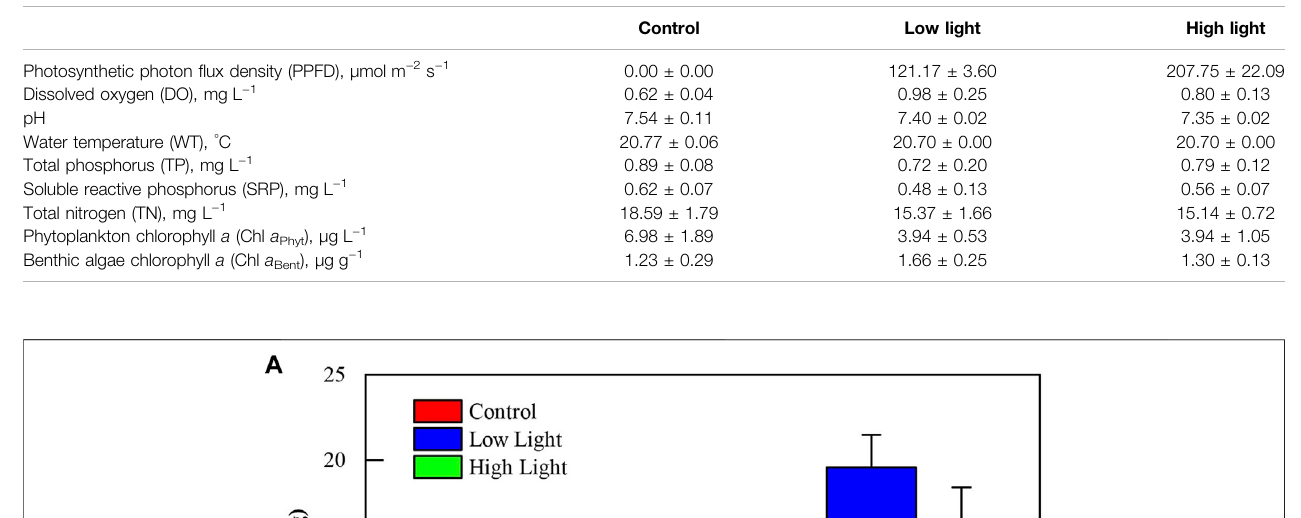
Frontiers in Environmental Science |